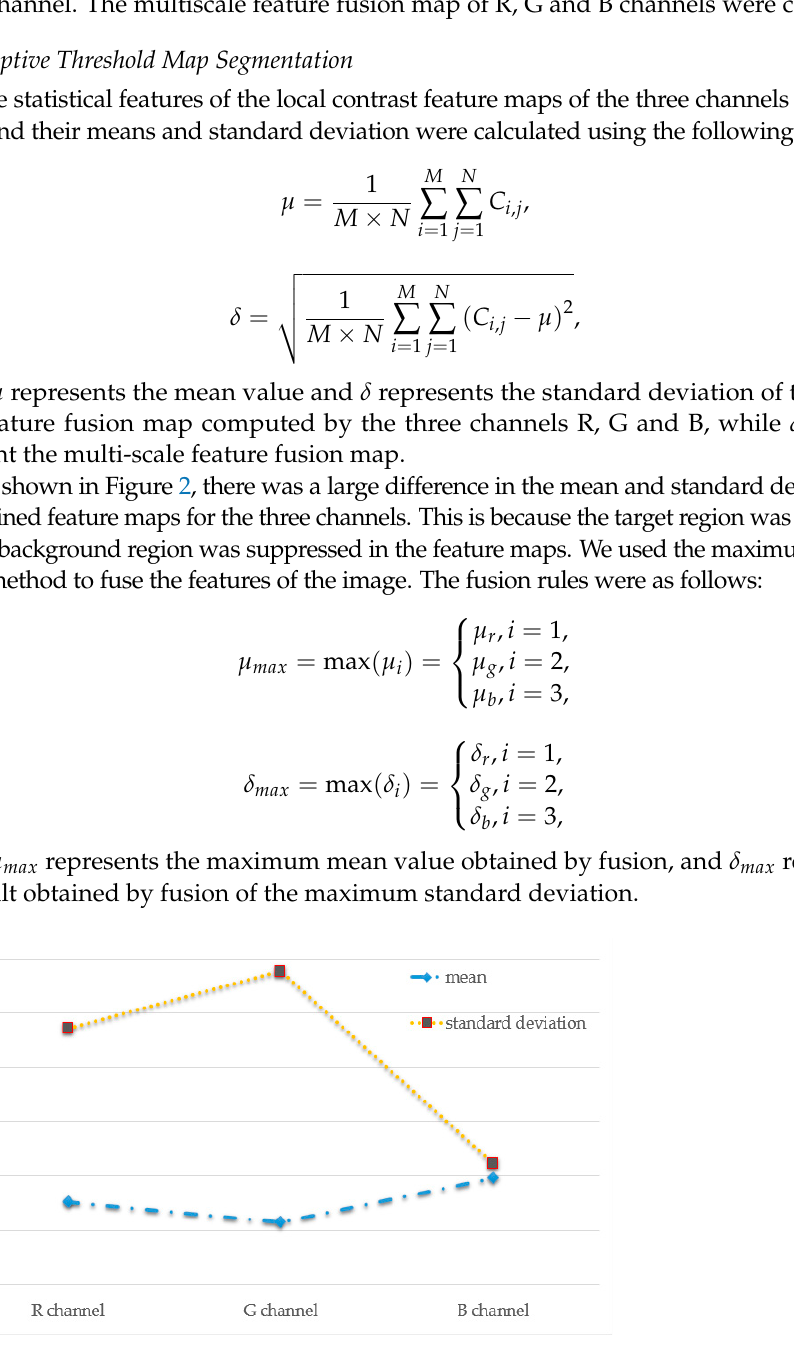
Figure 2. Mean and standard deviation plots for three-channel feature